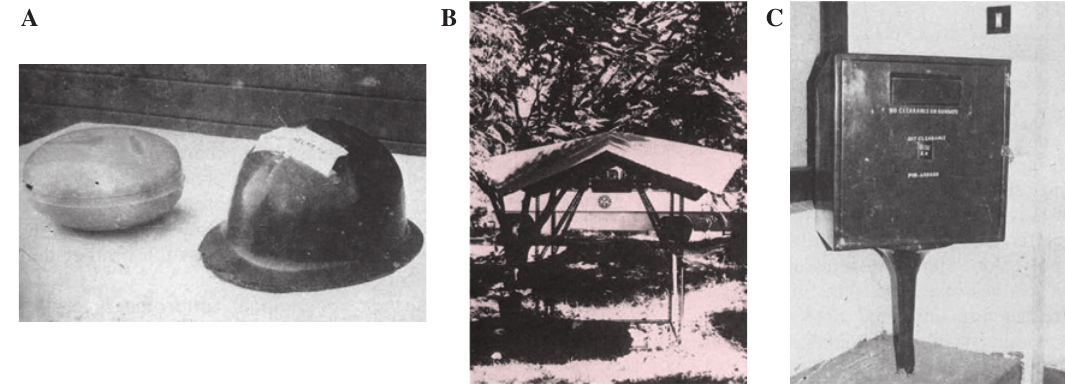
Figure 5: Components made of coir-polyester composites: (A) helmet, (B) roofing, and (C) post-box [16].